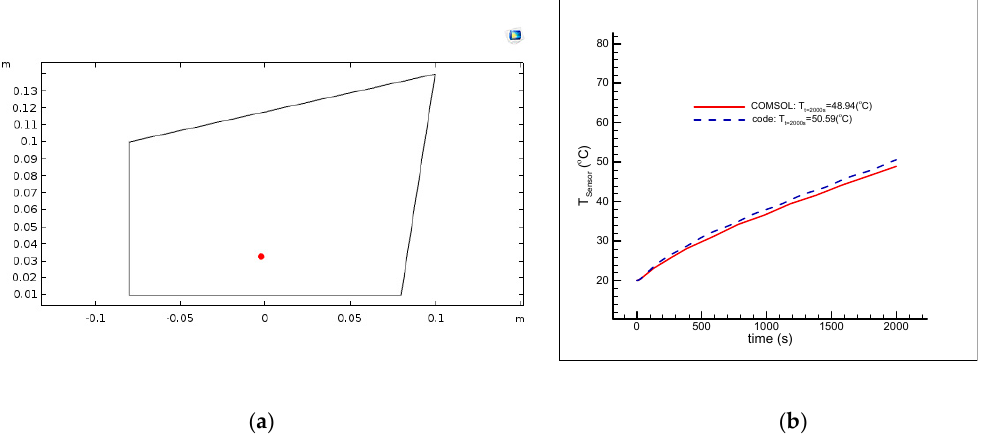
Figure 4. Comparison of temperature history at the sensor place, S ( M ,5) solver and the finite-element software COMSOL. ( a ) Sensor place; ( b ) temperature history.